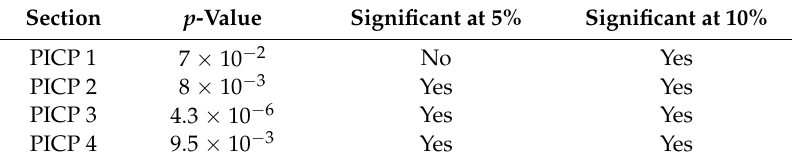
Table 7. Results of generalized Wilcoxon test for difference between pre and post-maintenance